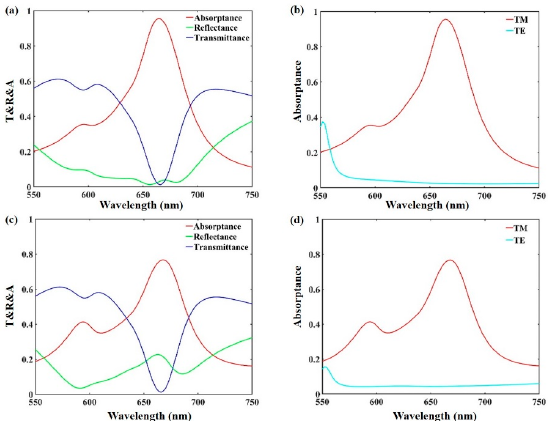
Figure 2. ( a , c ) show the absorption, transmission, and reflection spectra of the designed bilayer grating structure under forward and backward TM-polarized incidence, respectively. ( b , d ) show the absorption spectra of the proposed bilayer metasurface under forward and backward incident light with TE-polarized and TM-polarized irradiation, respectively.